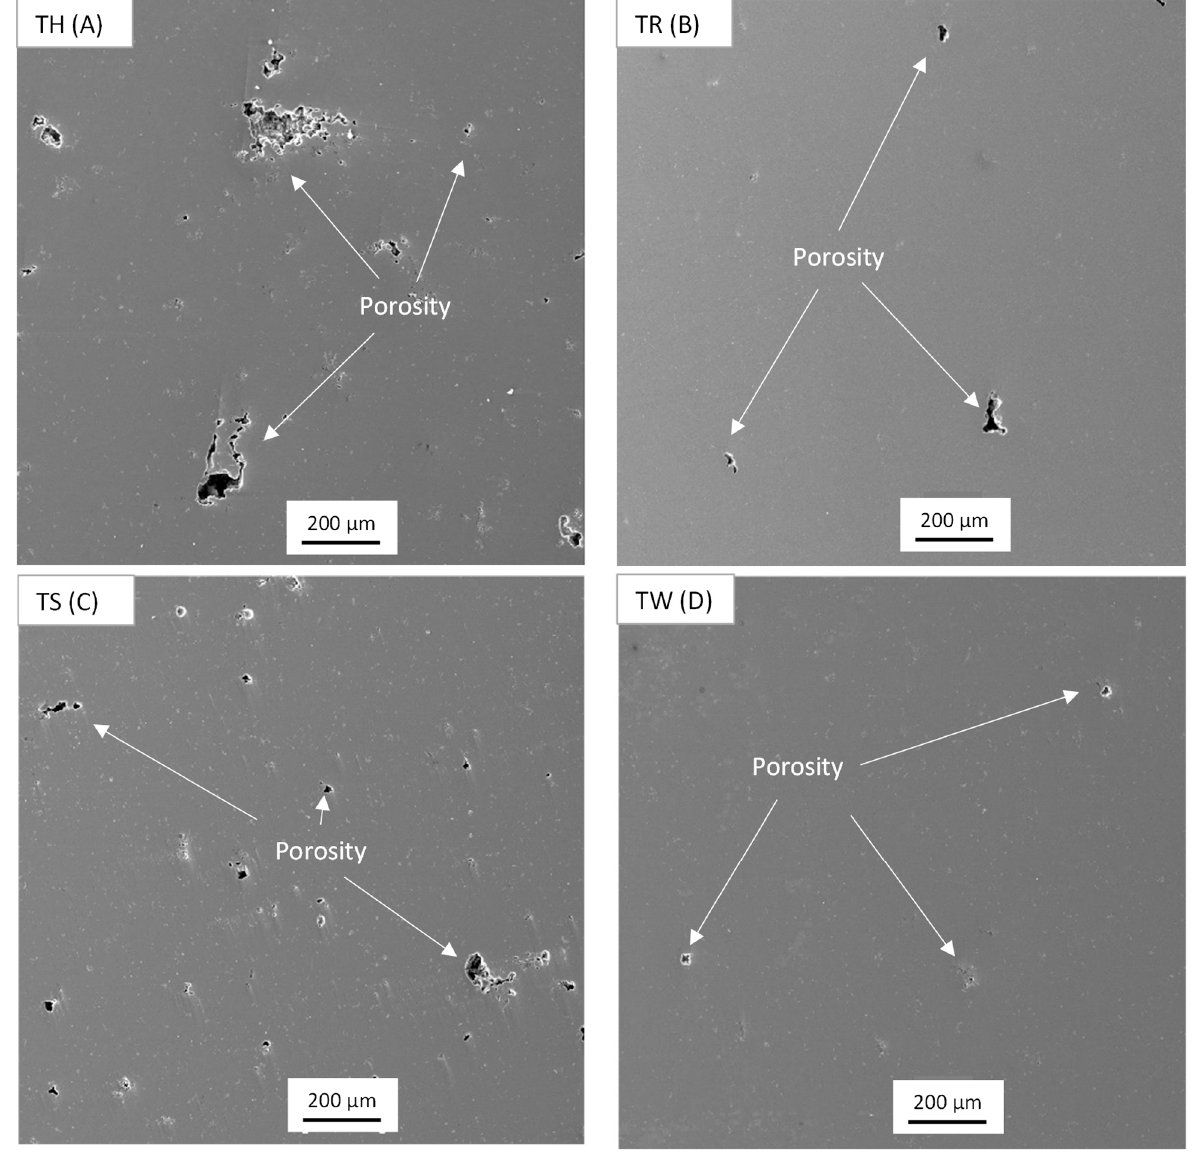
Figure 11. Representative un-etched micrographs for various regions of the T5 component showing the presence of porosities: ( A ) TH specimen; ( B ) TR specimen; ( C ) TS specimen; and ( D ) TW specimen.